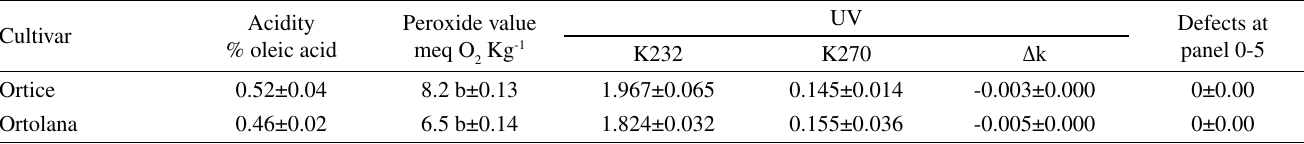
Table 2 - Quality indices of oils obtained from cv. Ortice and Ortolana olives mechanically harvested with a trunk shaker (mean±standard error)